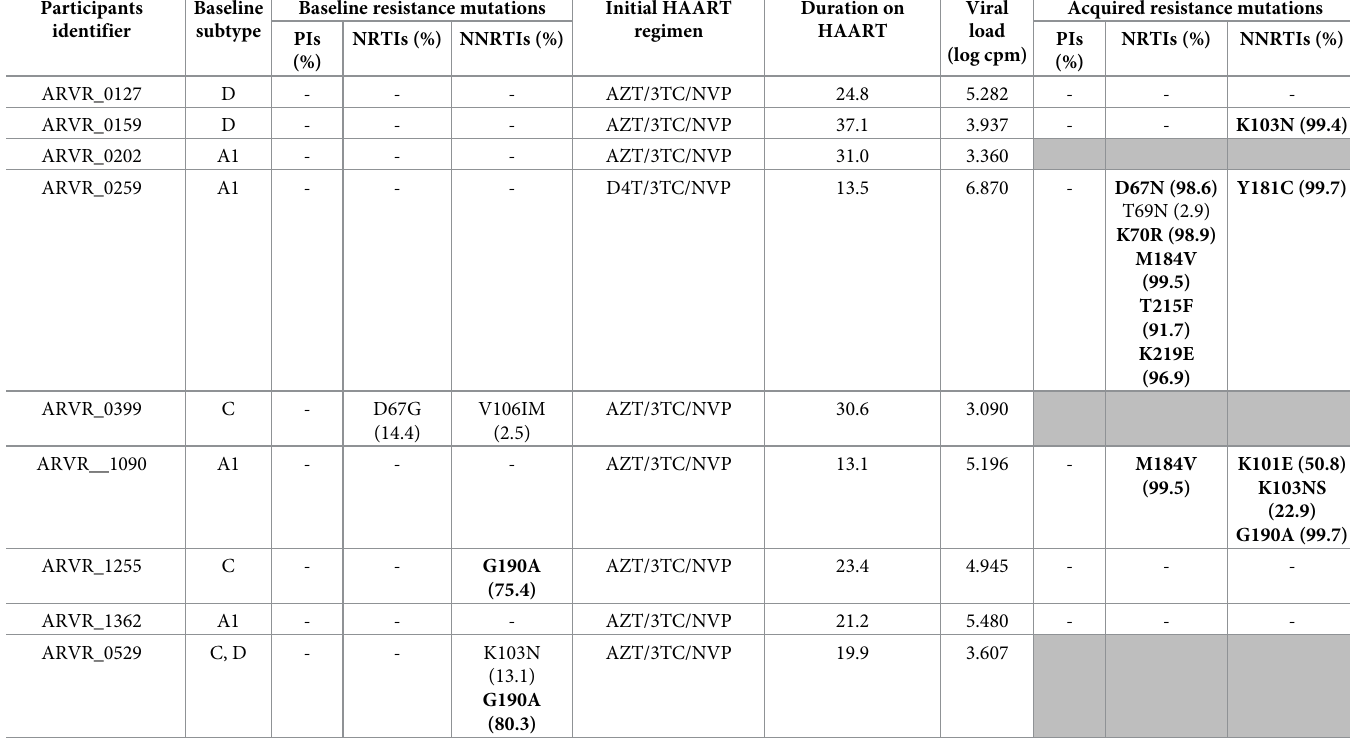
Table 4. Distribution and characteristics of participants with suspected virologic failure and HIV-1 acquired resistance variants from a HIV clinic in rural coastal Kenya (n = 48) � . Participants Baseline identifier